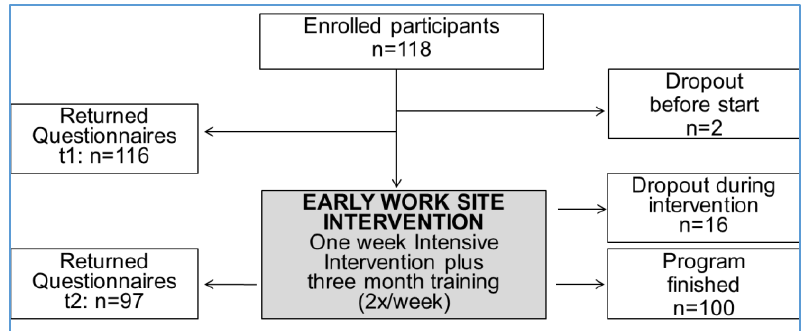
Figure 1. Study group: participation and dropout. Figure 1 . Study group: participation and dropout.